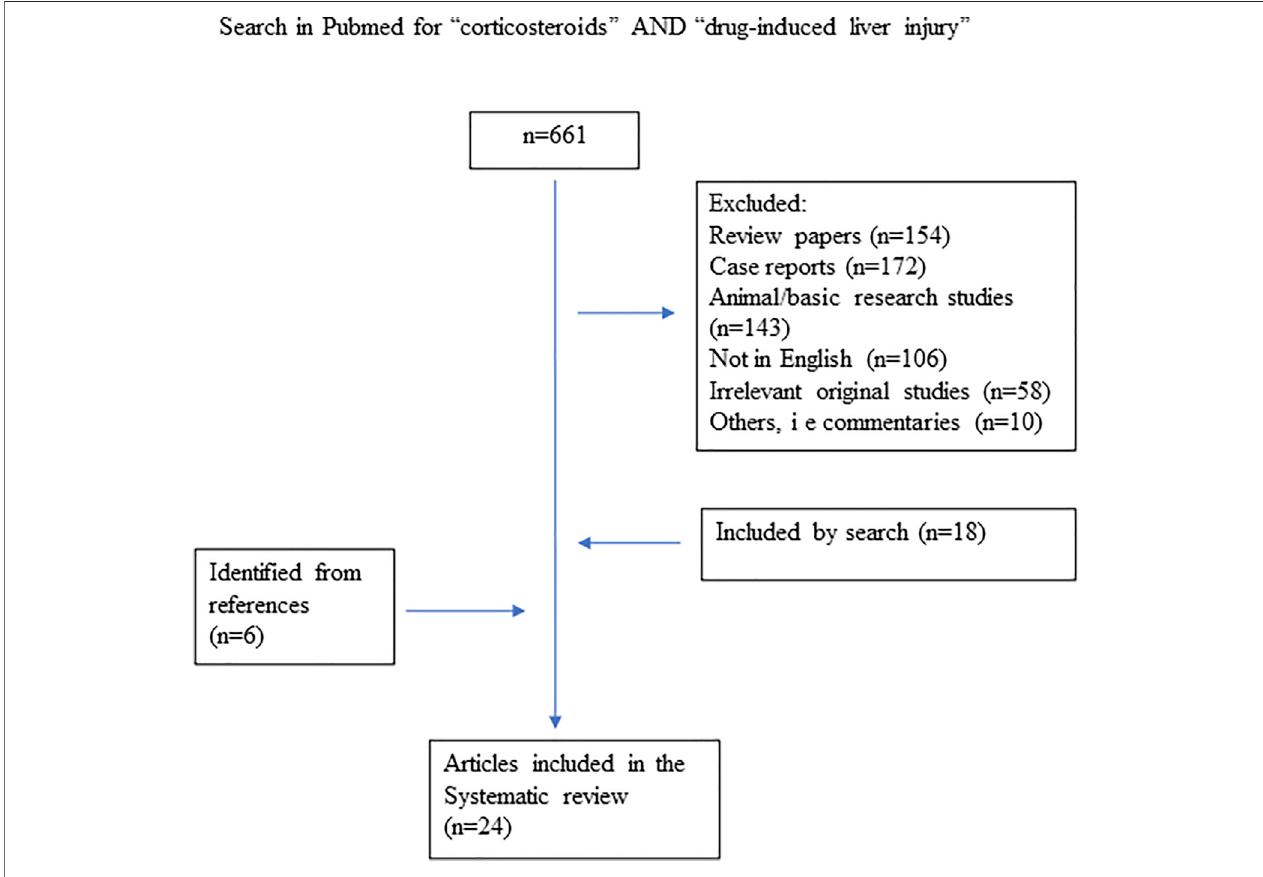
FIGURE 1 | Flow chart over the literature review